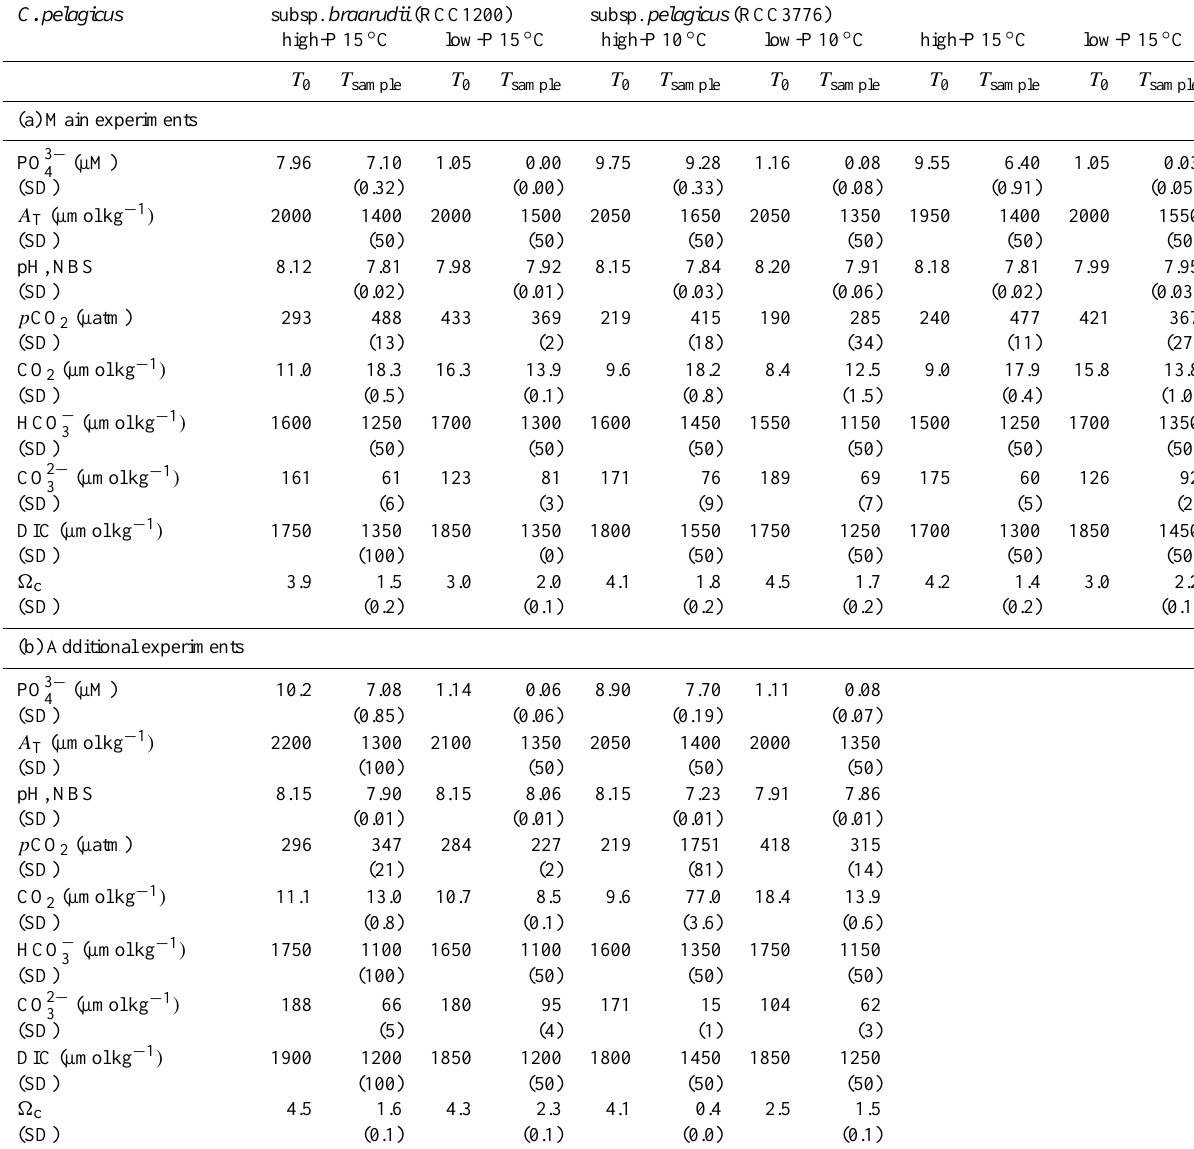
Table 1. Initial ( T 0 ) and residual ( T sample ) medium chemistry: phosphate concentrations and carbonate chemistry parameters in paired high-P and low-P media batch experiments with Coccolithus pelagicus subsp. braarudii (RCC1200) grown at 15 ◦ C and subsp. pelagicus (RCC3776) grown at 10 and 15 ◦ C. Initial values ( T 0 , n = 2) were measured directly from the high-P and low-P medium. The residual medium chemistry represents the average of triplicate batch cultures ( T sample , n = 3) with standard deviation (SD) in